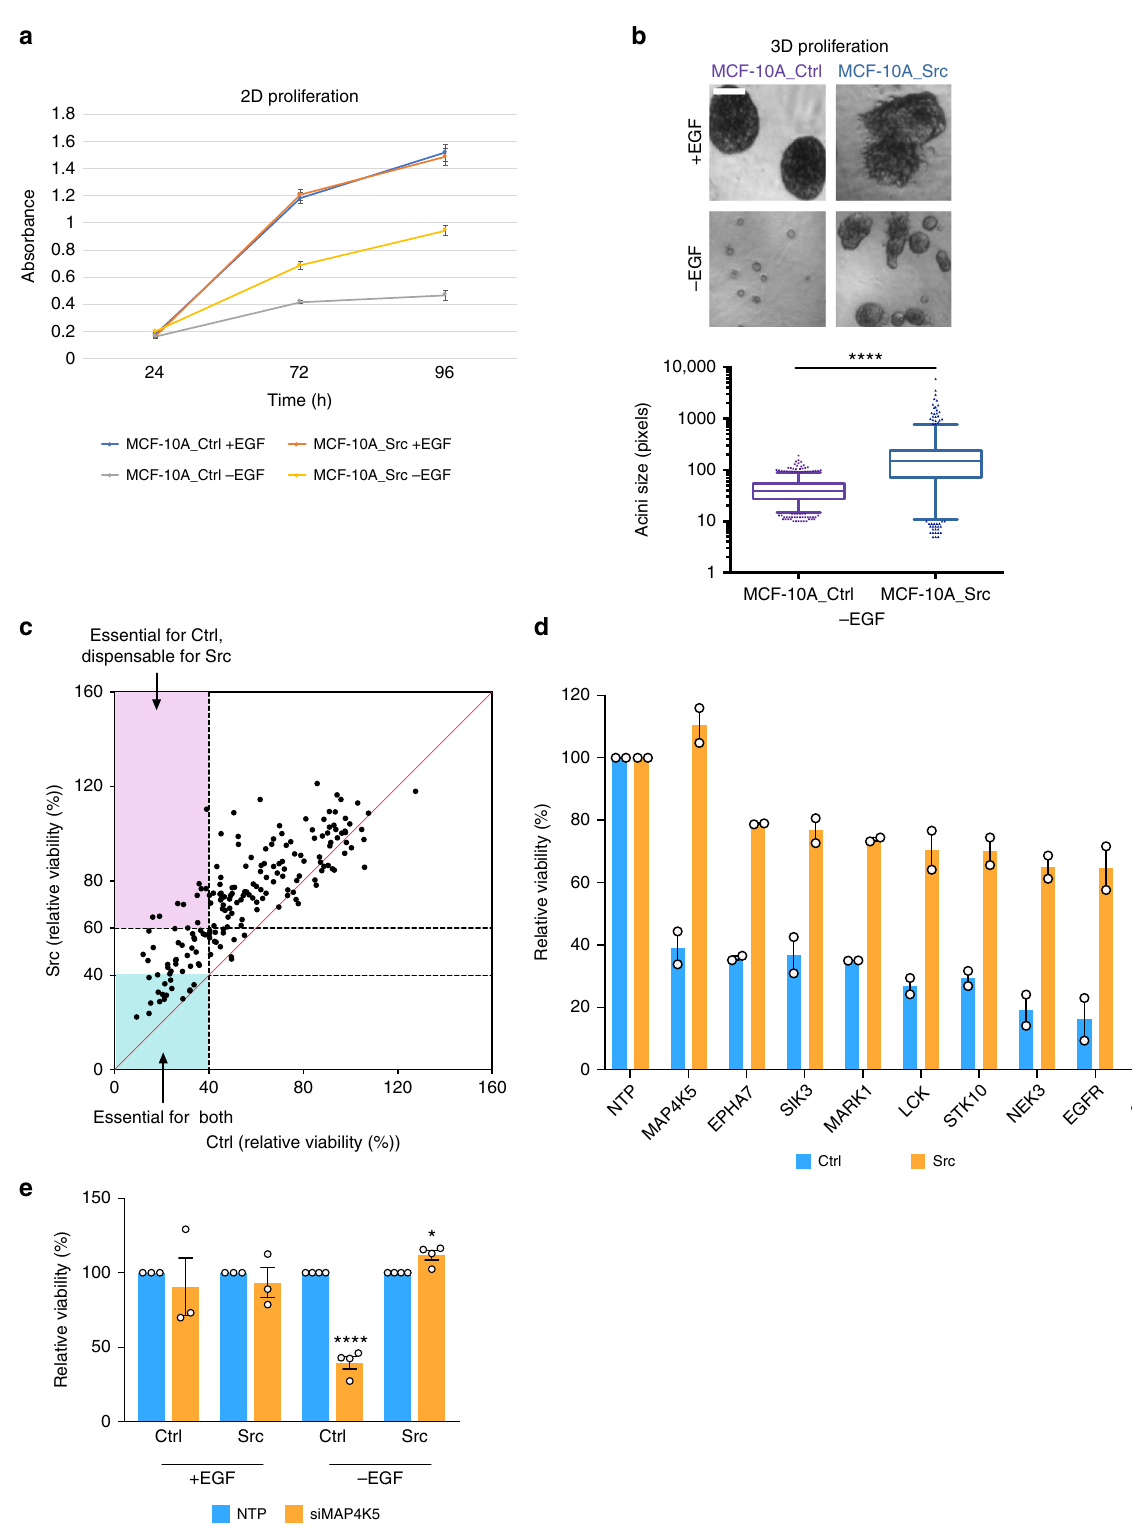
(Supplementary Figure 6b) reduced acinar growth (Fig. 5g), providing strong evidence that this role of SGK1 is kinase- dependent. In order to determine the biological basis for SGK1 dependency in MCF-10A_Src acini, we examined cleaved Caspase-3 and Ki67 levels by immuno fl uorescent microscopy as markers of apoptosis and proliferation, respectively (Fig. 6a).